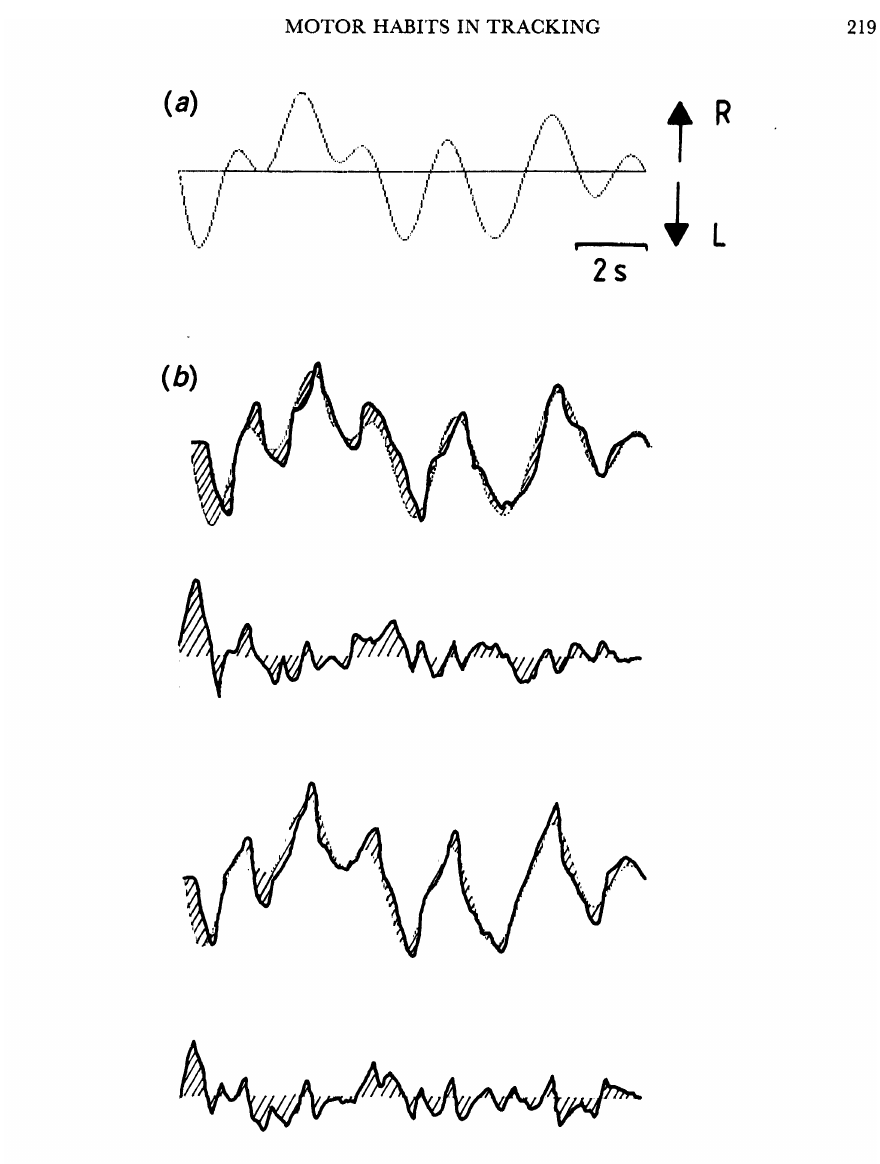
FIG. 1 (a) Target movement for random pursuit tracking. (b) Top traces: superposition of the target (thin line) and tracking curves (thick line); bottom traces: net "error" curves obtained by subtraction from the tracking of the target curve. Hatched area: tracking